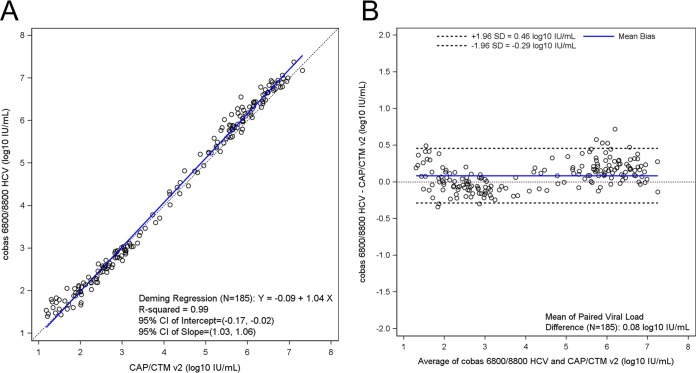
(a) Deming regression plot for cobas 6800/8800 HCV versus CAP/CTM v2 (n = 185). (b) Bland-Altman plot for cobas 6800/8800 HCV versus CAP/CTM v2 (n = 185). CAP/CTM v2, Cobas AmpliPrep/Cobas TaqMan HCV quantitative test; CI, confidence interval.